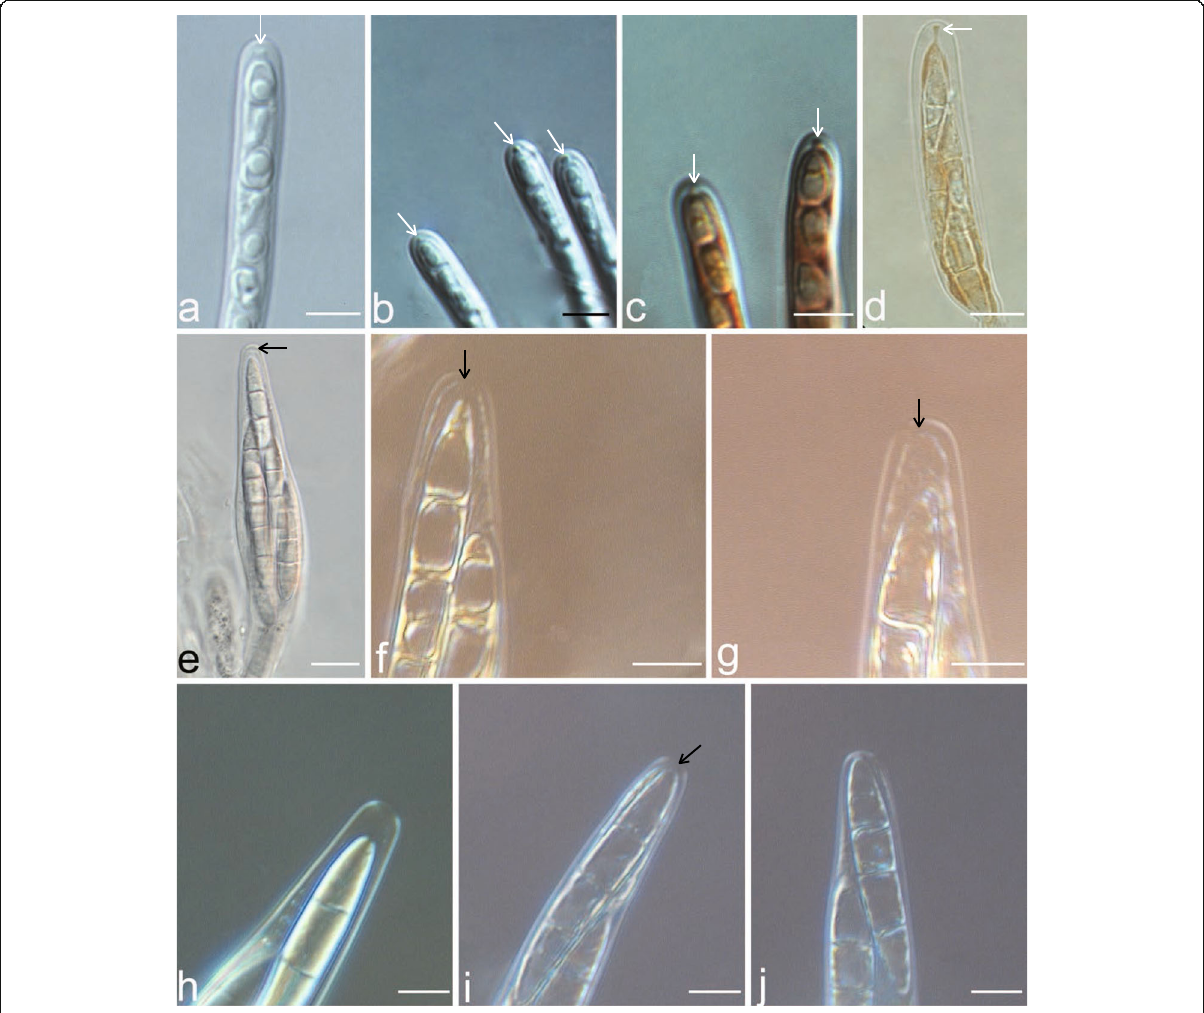
Fig. 2 Strigula nitidula (HMAS – L0139358): a – b Ascus. c Ascus showing iodine reaction in Lugol ’ s solution. Strigula cf. smaragdula GD2015025 – 5 (HMAS – L0138067): d Ascus showing iodine reaction in Lugol ’ s solution. Tenuitholiascus porinoides ( e – g HMAS – L0139638; h – j HMAS – L0141348) e Ascus. f – g Ascus with iodine reaction in Lugol ’ s solution. h Ascus. i – j Ascus with iodine reaction in Lugol ’ s solution. White arrows indicate the ocular chamber, and black arrows indicate the non-amyloid dome. Scale bars: a – c = 5 μ m, d = 10 μ m, e – j = 5 μ